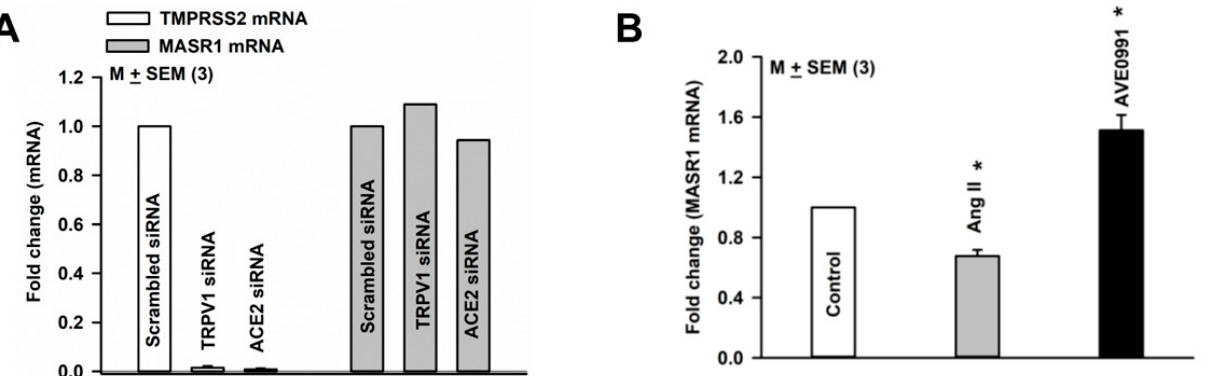
Figure 8. Regulation of MASR1 and TMPRSS2 mRNA in HBO cells: ( A ) TRPV1 siRNA and ACE2 siRNA-induced changes in MASR1 and TMPRSS2 mRNA expression in HBO cells; ( B ) effect of Ang II and AVE0991 on MASR1 mRNA expression in HBO cells. Values are means of qPCR performed in triplicate. * p = 0.0014 (Ang II); * p = 0.0075 (AVE0991).